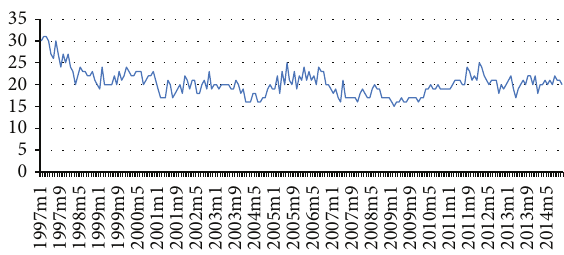
Figure 12: The number of total links with respect to 10 regions in East and Southeast Asia (window length = 36